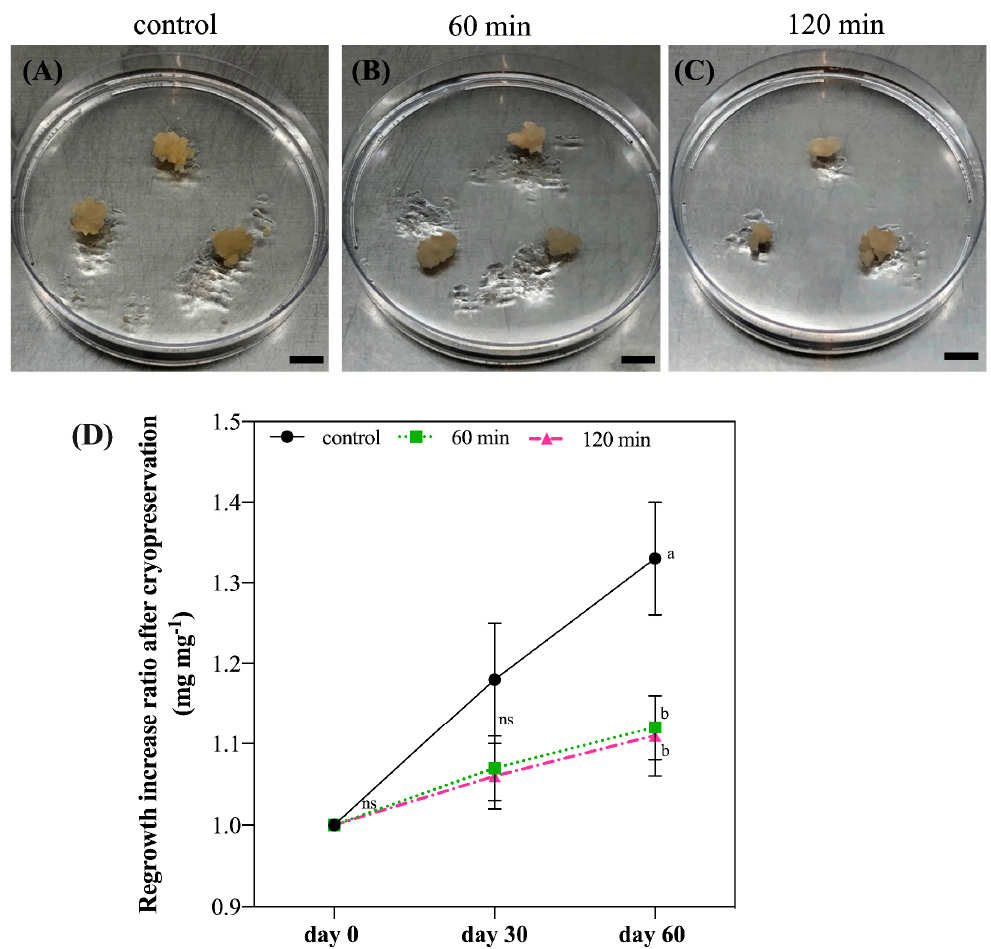
Figure 4. Regrowth of G. chacoensis embryogenic cultures after cryopreservation procedure: ( A ) con- trol after 60 days; ( B ) 60 min incubation culture at 60 days: ( C ) 120 min incubation culture at 60 days; ( D ) regrowth increase ratio (mg mg − 1 ) at 30 and 60 days after cryopreservation for control, 60 min and 120 min incubation cultures. Bars indicate the standard deviation of the mean. Lowercase letters represent significant differences between incubation times on each day, according to the Tukey test ( p < 0.05). ns: not significant. Bar ( A – C ): 1 cm.